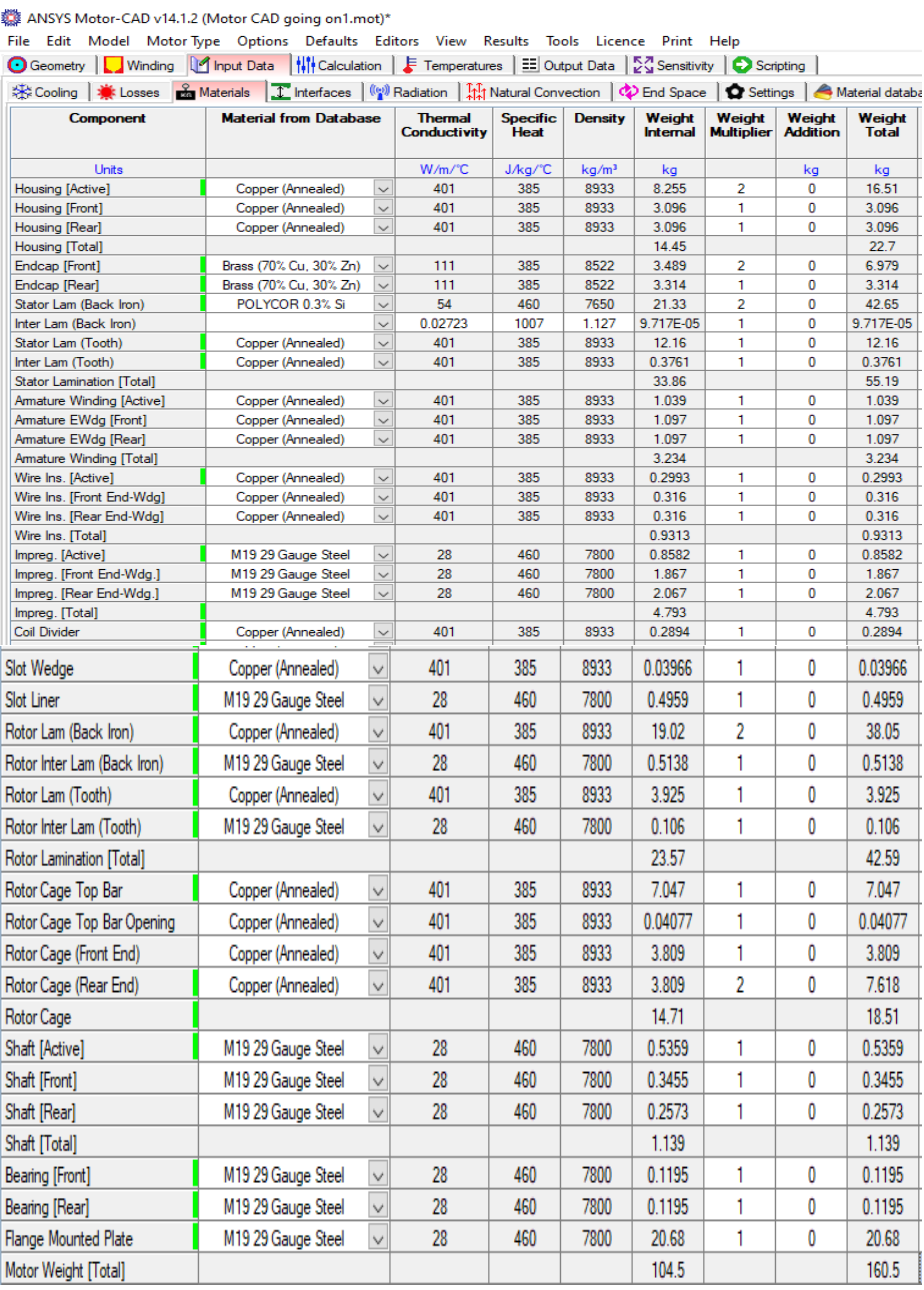
Figure 5. Material Consumptions of Designed